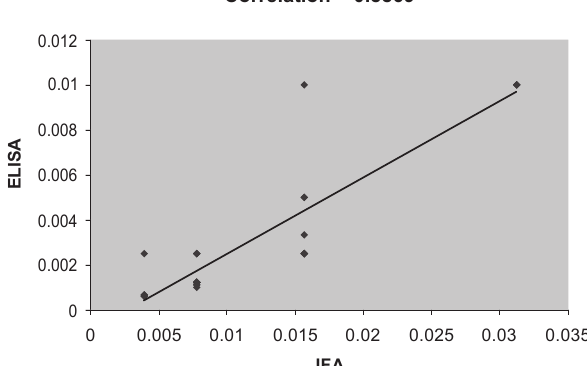
Fig. 1. – Cut off point for the standard positive and negative sera. Cut off = Mean (OD positive sera) + 2 Standard deviation Cut off = 1.257 Optimum sera for cutoff = 1/100 Sample No 1 to 6 = Positive sera Sample No 7 to 9 = Negative sera OD = Optical density